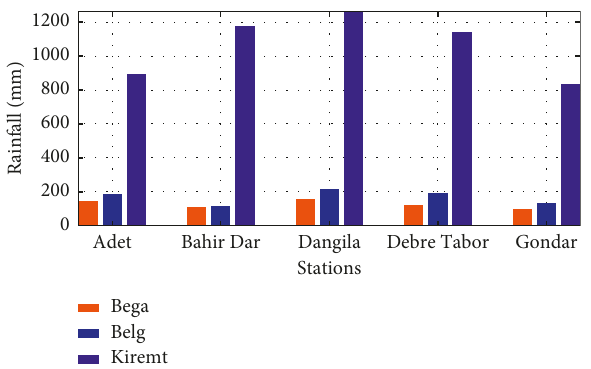
Figure 3: Mean seasonal amount of rainfall for each station from 1979 to 2015.